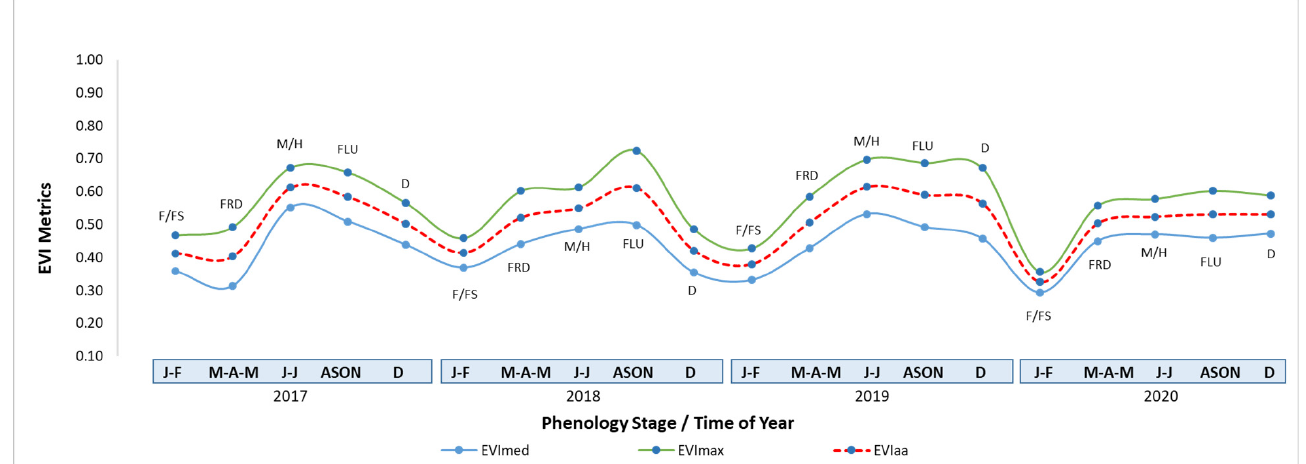
Figure 6. Temporal profile of mango in relation to the phenology cycle across the 4-year time series of median and maximum EVI metrics (EVI med , EVI max ) together with their overall yearly average (EVI aa ) from the Akuni Papa Farm.